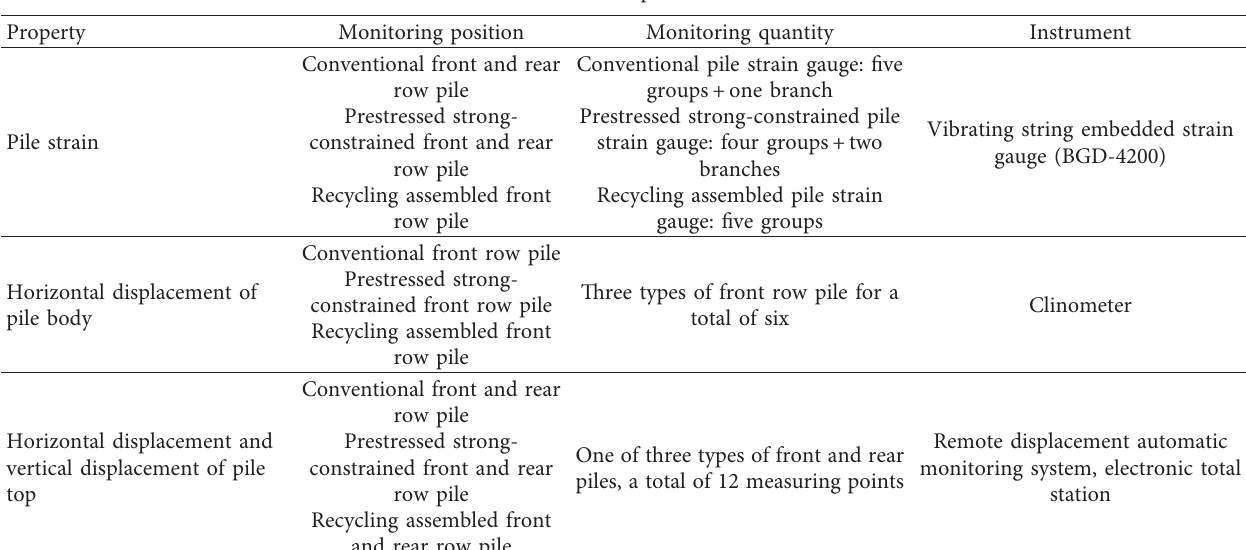
Table 2: Test procedure.